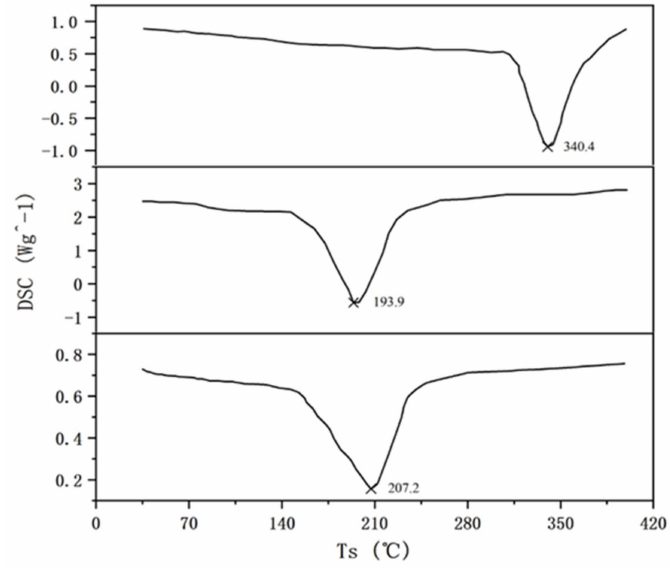
Figure 6. DSC thermal spectra of the samples JM186, #1, and #2.